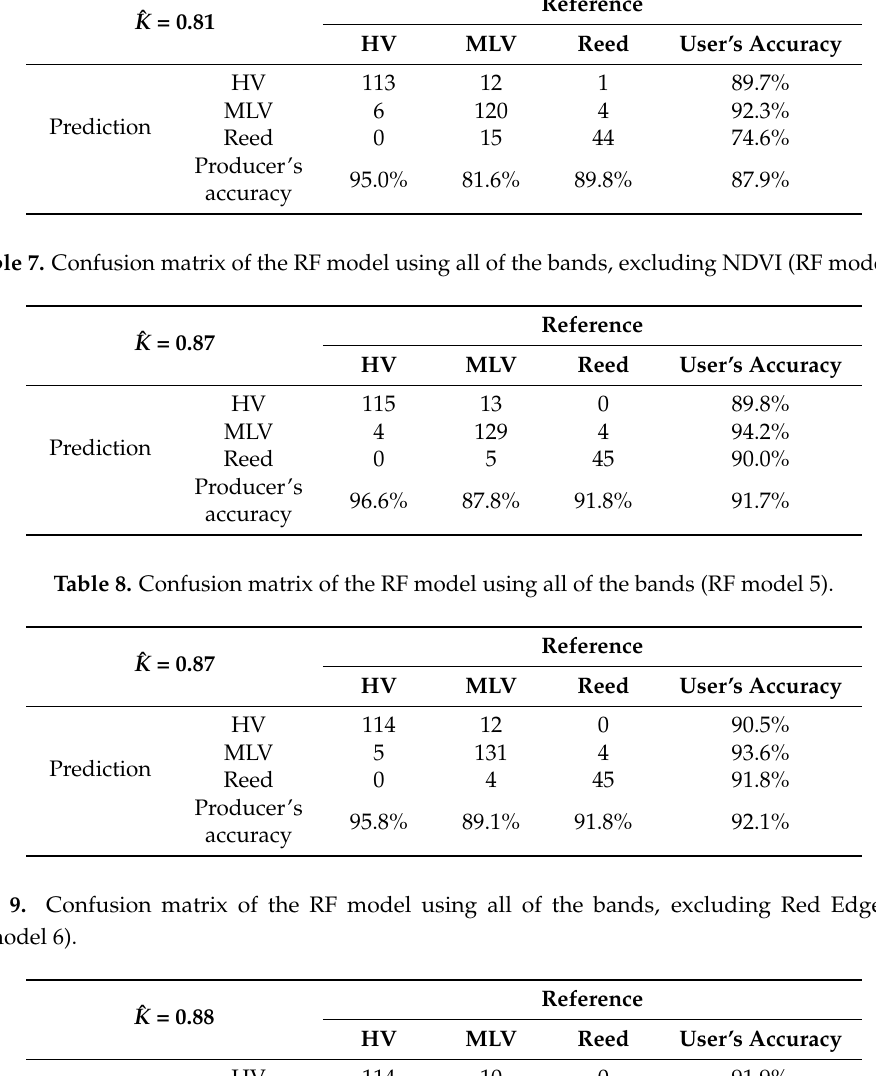
Table 6. Confusion matrix of the RF model using RapidEye and Landsat (5 October) (RF model 3). ˆ K = 0.81